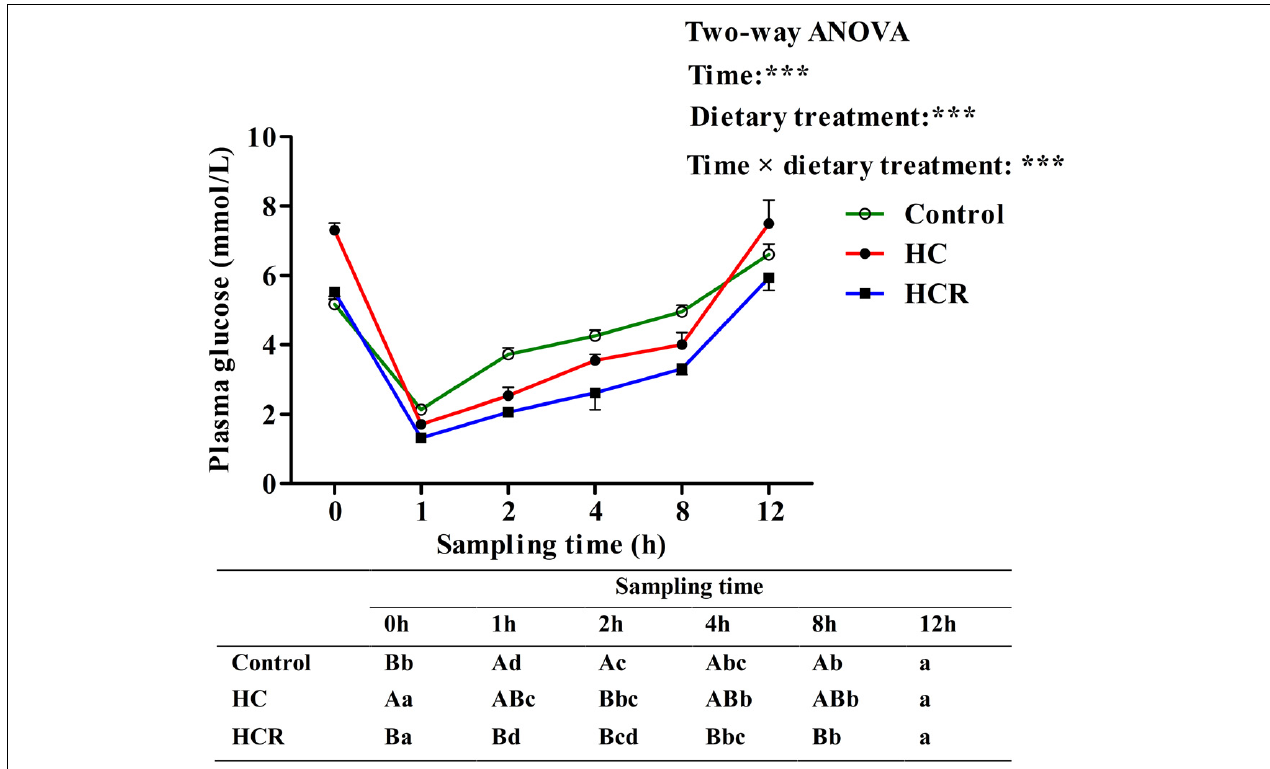
FIGURE 7 | Plasma glucose levels of blunt snout bream subjected to an insulin load after the adaption to different experimental diets. Each data represents the mean of four replicates. Different lower-case letters indicate significant differences ( P < 0.05) at different time points within each treatment, whereas different capital letters indicate significant differences ( P < 0.05) among these three treatments at each sampling point. ∗∗∗ P < 0.001. Control, diet with 30% carbohydrate level; HC, diet with 41% carbohydrate level; HCR, diet with 41% carbohydrate and 0.04%